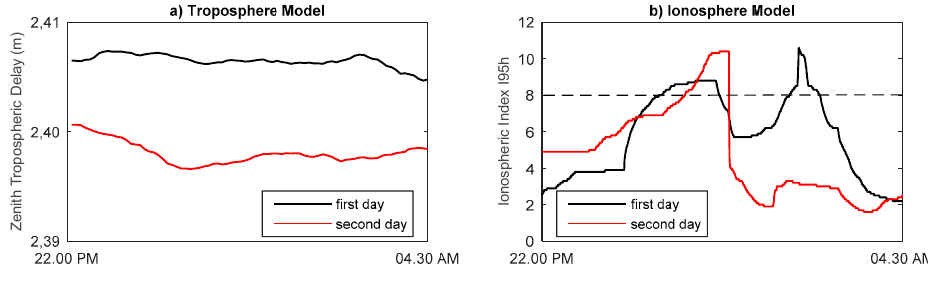
Figure 5. Atmospheric corrections ( a : Troposphere Model, b : Ionosphere model).